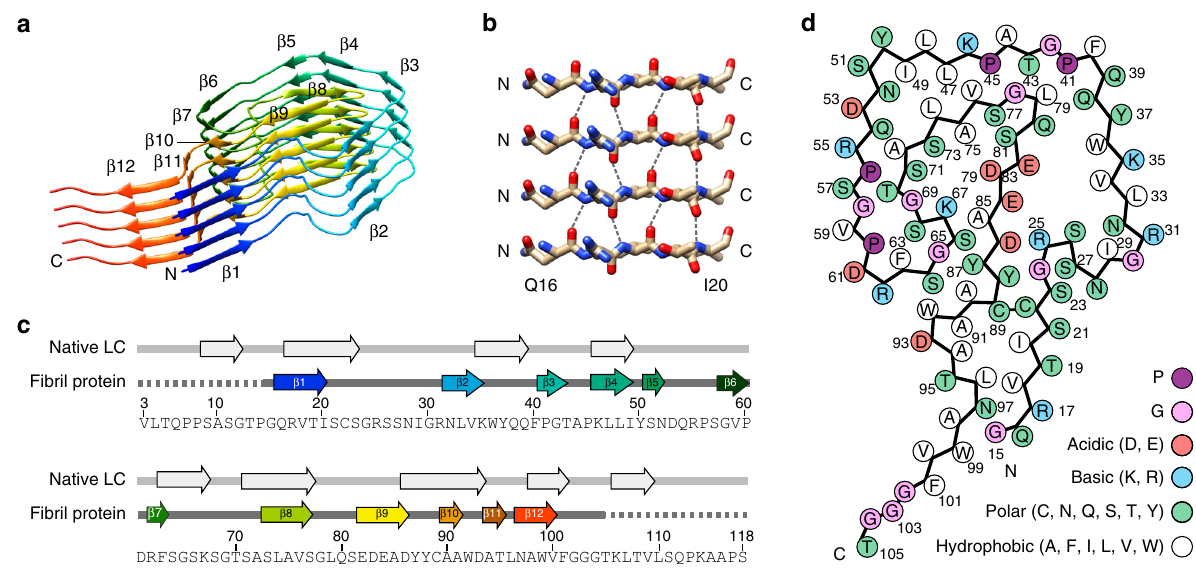
Fig. 2 Fibril protein β -sheet structure. a Ribbon representation of a stack of fi ve fi bril proteins rainbow colored from N-terminus to C-terminus. b Close-up of the parallel cross- β sheet β 1. c Position of the β -strands (arrows) in the fi bril protein and in the natively folded LC as de fi ned in PDB entry 1BJM 60 . Residue numbers refer to the native LC without signal sequence. The color of the β -strands in the fi bril corresponds to panel a . Dotted gray line refers to the part of the protein that is disordered in the fi bril. d Schematic representation of the fi bril protein packing